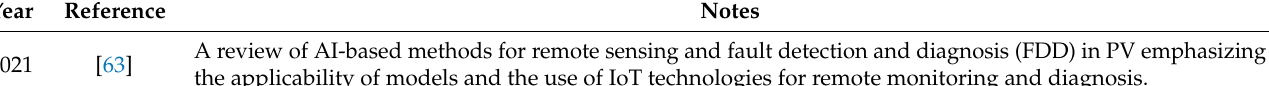
Table 4. Review papers for fault/anomaly detection and diagnosis in PV. Publication year considered: